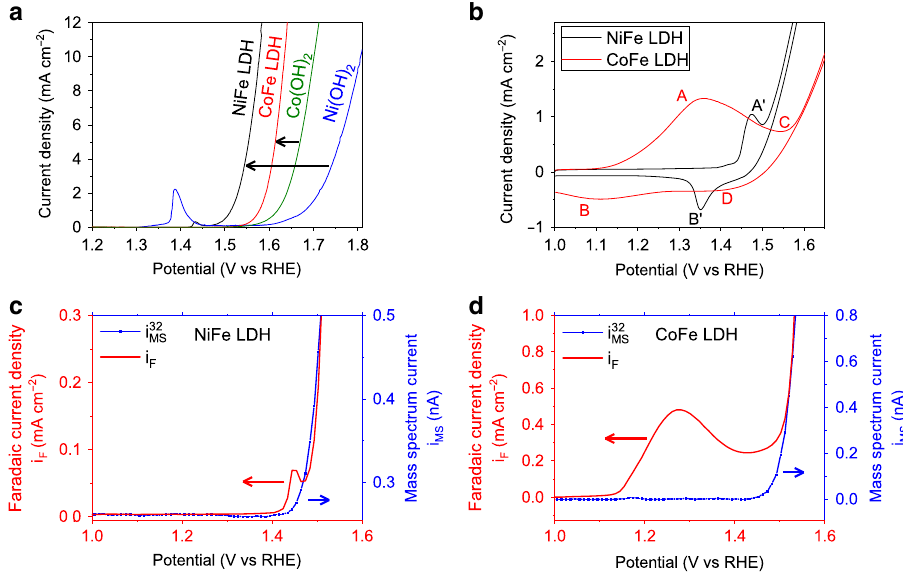
Fig. 1 Surface chemistry and OER of NiFe and CoFe LDHs. a Linear sweep voltammetry of NiFe LDH (black), CoFe LDH (red), β -Ni(OH) 2 (blue), and β -Co (OH) 2 (green) at a scan rate of 1 mV s -1 in puri fi ed 0.1 M KOH by RDE (1600 r.p.m.). Catalyst loading on GC electrodes: 0.1 mg cm − 2 . b Stable curves obtained in cyclic voltammetry of NiFe LDH (black) and CoFe LDH (red) in 0.1 M KOH in the grazing incident cell. Redox features are indicated with capital letters. c , d Differential electrochemical mass spectrometry (DEMS) of NiFe LDH ( c ) and CoFe LDH ( d ) during a linear sweep voltammetry (LSV) in 0.1 M KOH. The faradaic current normalized by the geometric area is shown in red, whereas the mass spectrum current related to mass m / z = 32 is shown in